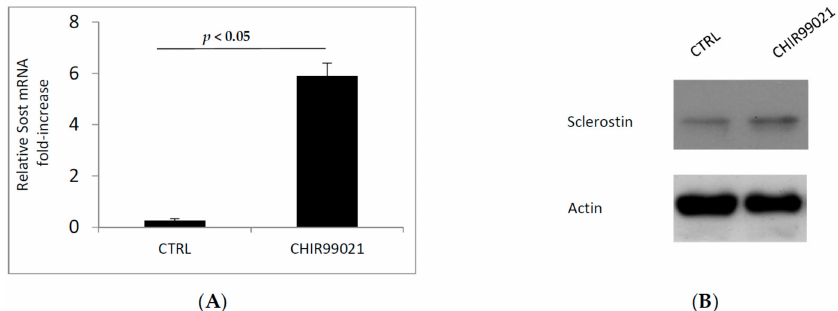
Figure 7. ( A ) mRNA was extracted from MLO-Y4 cells treated with CHIR99021 at 100 nM for 48 H. The expression of Sclerostin gene (Sost) was evaluated by RT-PCR. ( B ) A replicate of same samples were extracted for immunoblotting procedure. 40 µ g of protein extracts were separated in SDS-PAGE and Sclerostin protein was revealed.